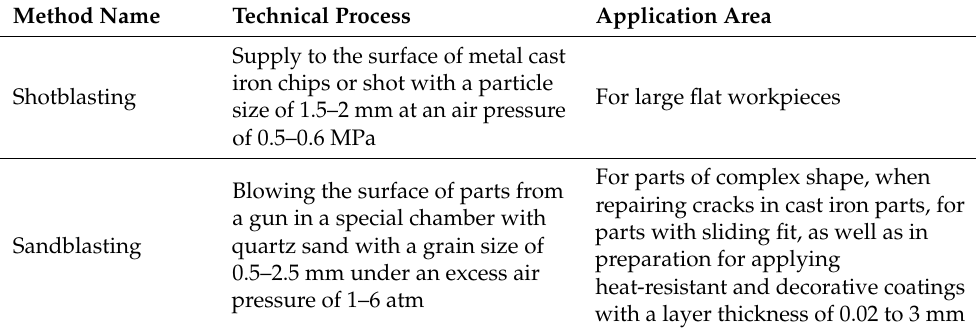
Table 1. The main methods of mechanical preparation of the surface of parts for